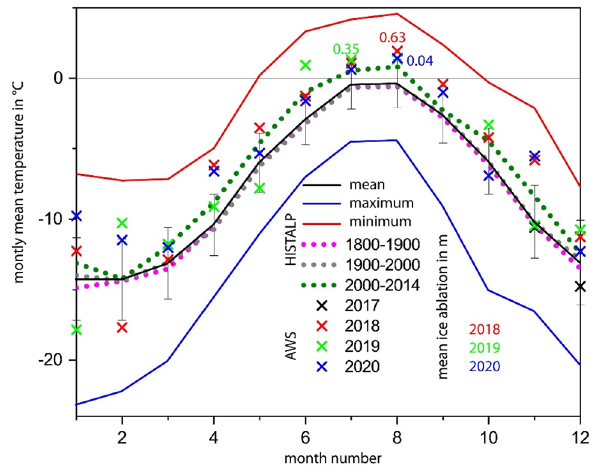
Figure 5. Mean, maximum and minimum monthly means for the total length of the record (1780–2014, Table S4) show that, on average, monthly means are below zero even in summer, but positive mean temperatures have occurred between May and October. The temperatures observed at the AWS are clearly above the mean, even for 2000–2014. Centennial averages are close to the mean and below